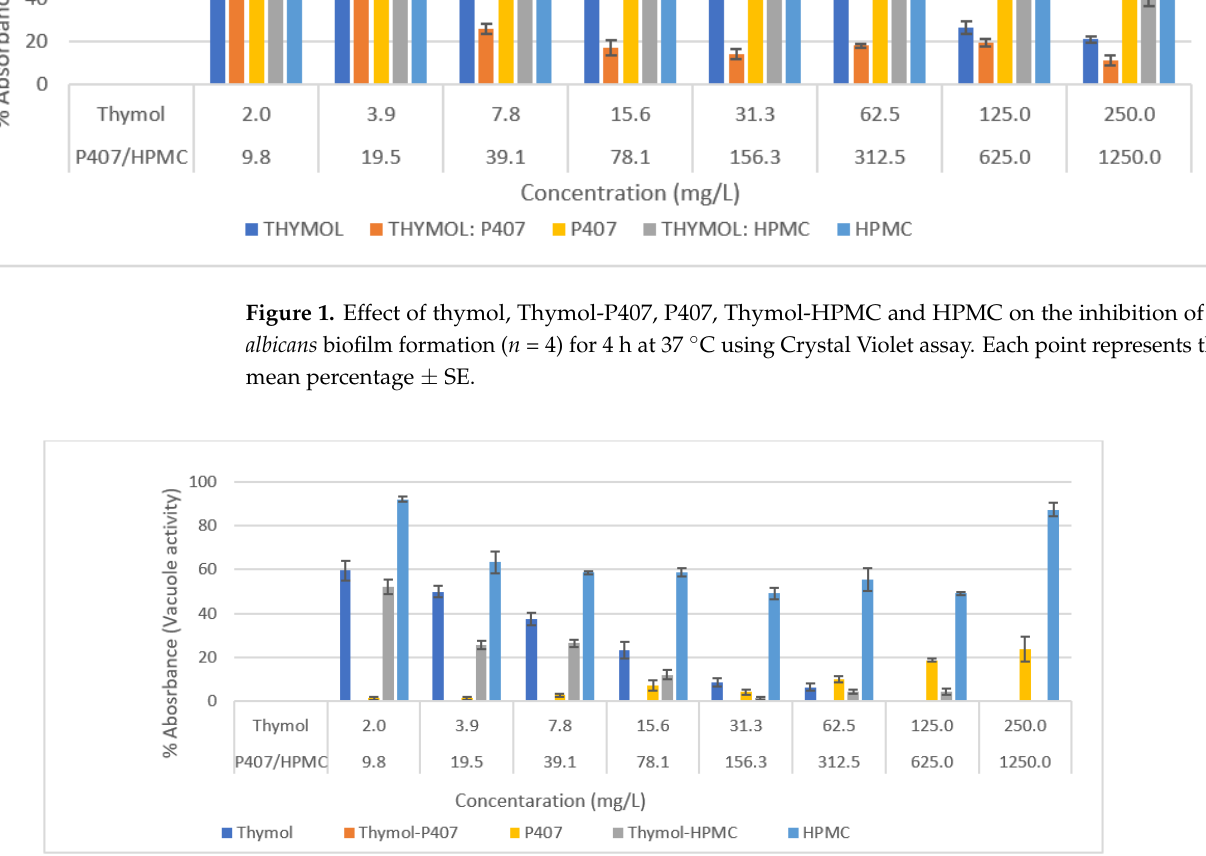
Figure 2. Effect of thymol, Thymol-P407, P407, Thymol-HPMC and HPMC on the inhibition of C. albicans biofilm formation ( n = 4) for 4 h at 37 °C using Neutral red uptake assay. Each point repre- sents the mean percentage ± SE.